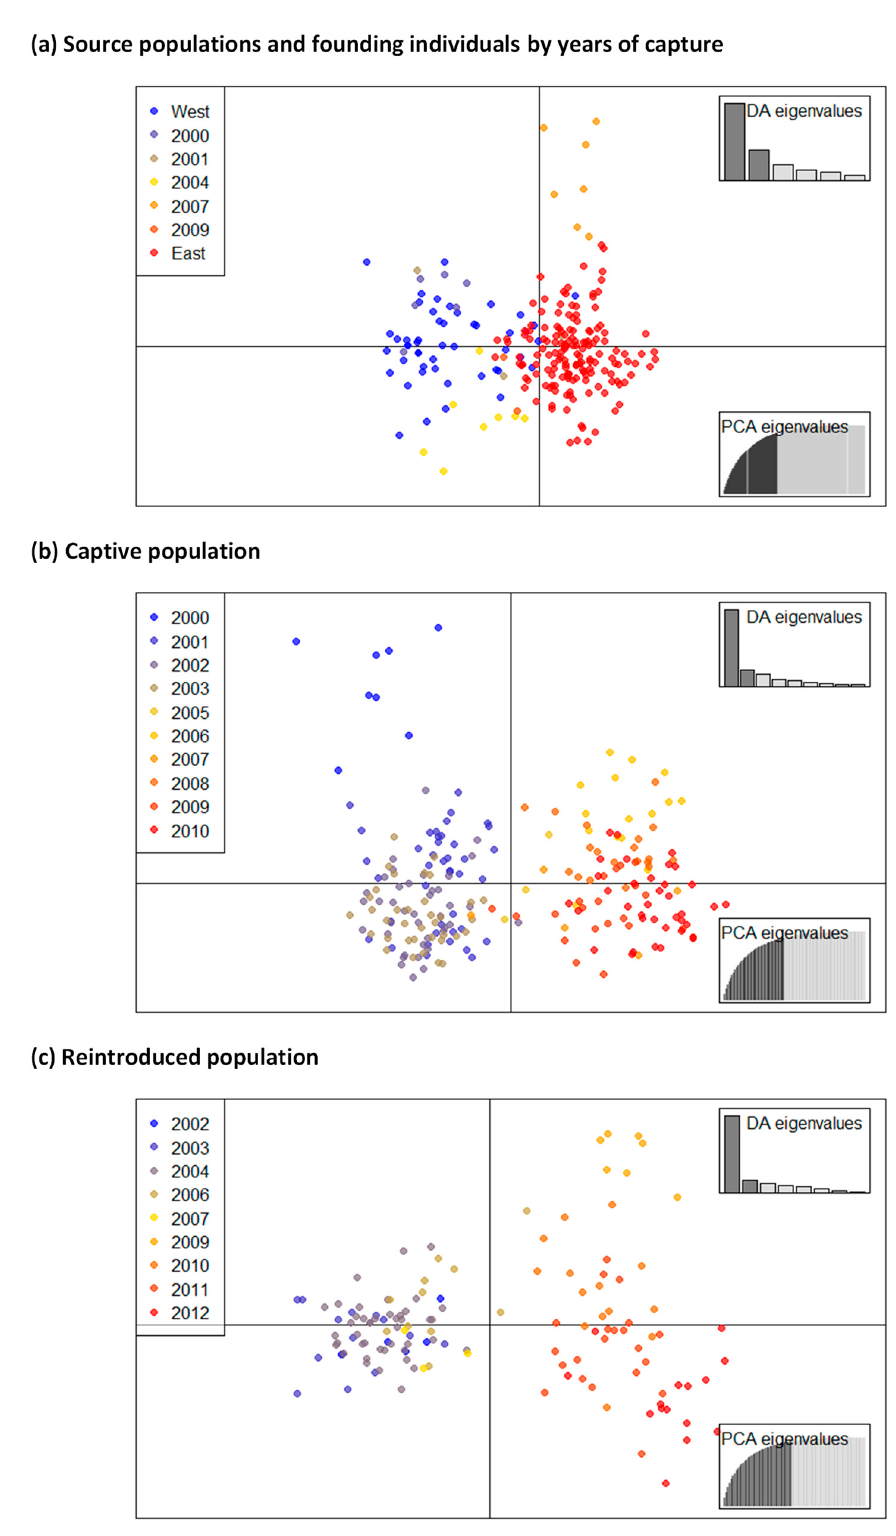
Figure 4. Scatterplot of the DAPC analysis showing the first two principal components. Clusters in different colors represent different collection years, except the source populations, which represented individuals pooled across the 2000–2012 collections. Dots represent Parantechinus apicalis individuals. Insets show the histogram of discriminant analysis eigenvalues. ( a ) Shows the source populations and founders introduced to the breeding program in different years; ( b ) shows the captive population; and ( c ) shows the reintroduced population.